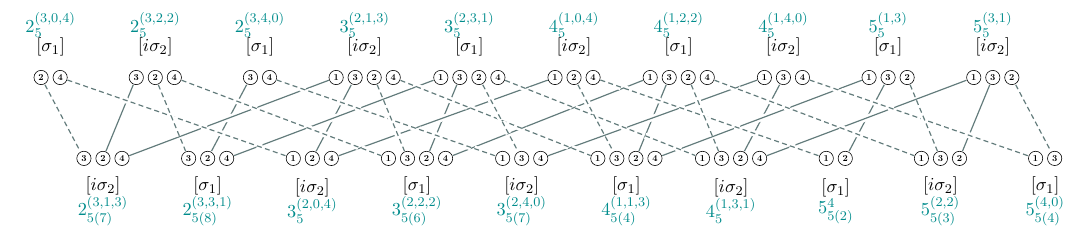
Figure 8 . T -duality chain of the E (5;6) -branes.